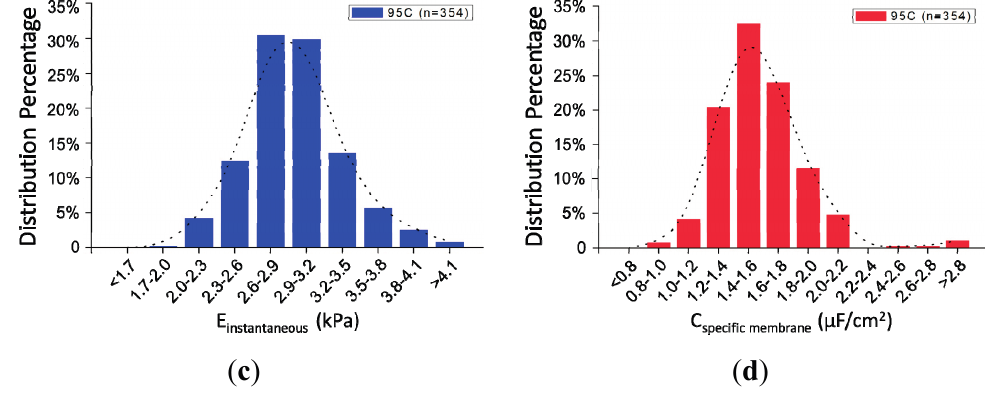
Figure 5. ( a ) A scatter plot of C specific membrane vs. E instantaneous for 95C cells ( n = 354) with quantified E instantaneous of 2.96 ± 0.40 kPa and C specific membrane of 1.59 ± 0.28 μ F/cm 2 shown in ( b ). ( c ) and ( d ) Distribution percentages of E instantaneous and C specific membrane for 95C cells with the peak of E instantaneous within the range of 2.6–2.9 kPa and C specific membrane within the range of 1.4–1.6 μ F/cm 2